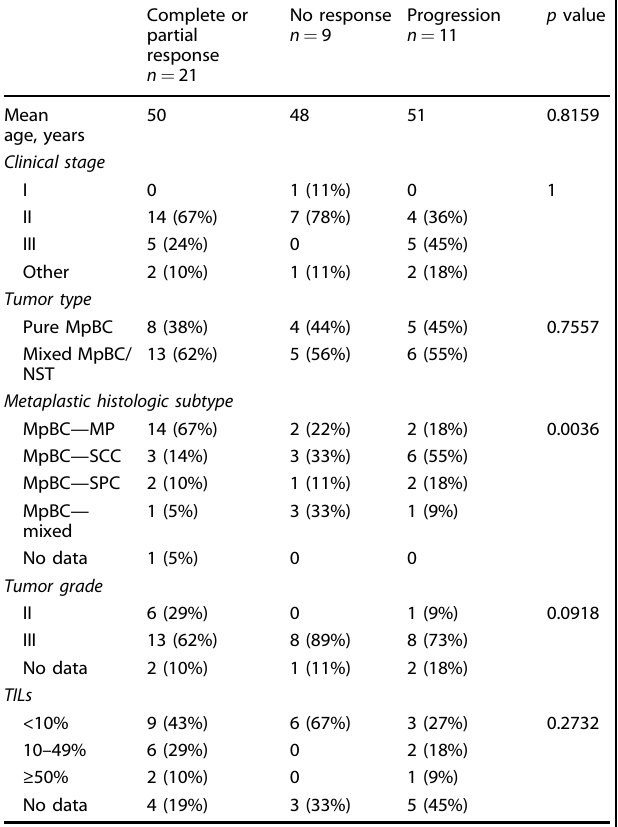
Table 2. Clinicopathological characteristics in 41 patients with clinical and radiological response assessment.